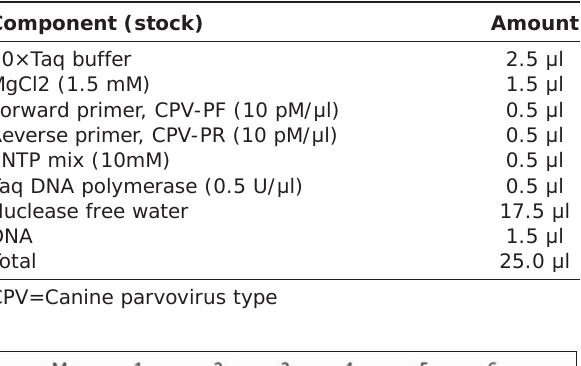
Table-2: Polymerase chain reaction.